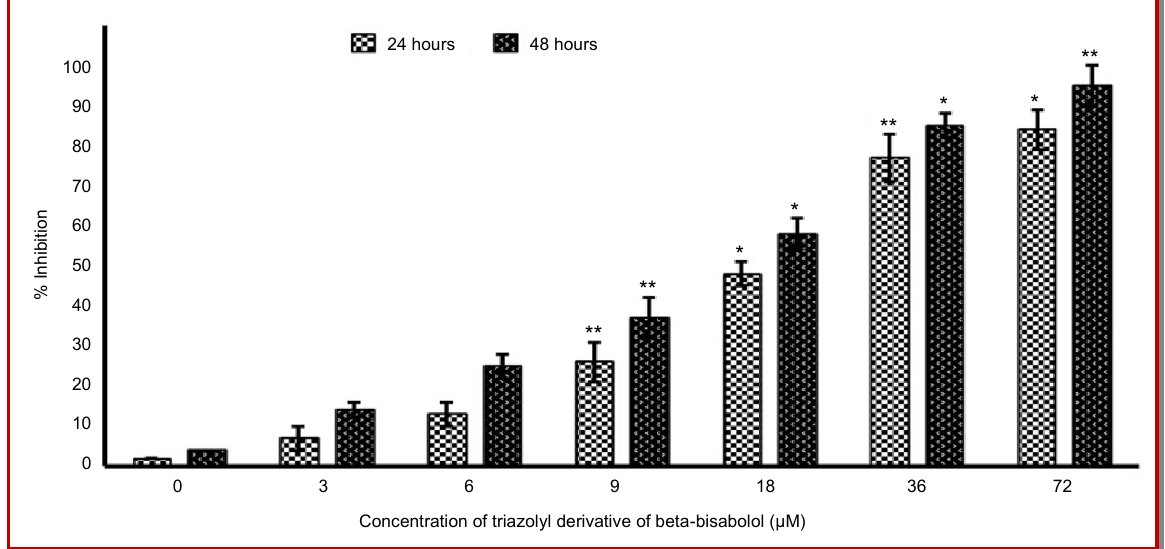
Figure 2: Dose-dependent and time-dependent cytotoxic effect of triazolyl derivative of beta-bisabolol in human cervical cancer cells (ME-180). Data are shown as the mean ± SD of three independent experiments. *p<0.05, **p< 0.01, vs 0 µM (control)